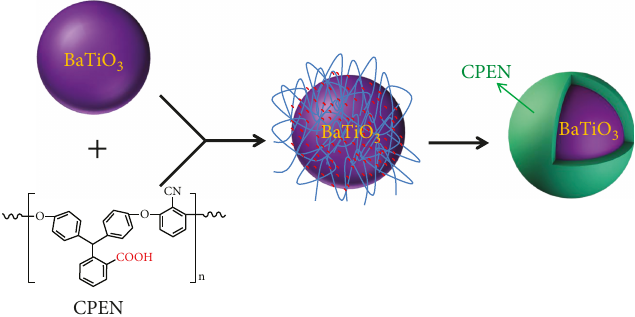
Figure 5: Synthetic route for the core-shell-structured BaTiO